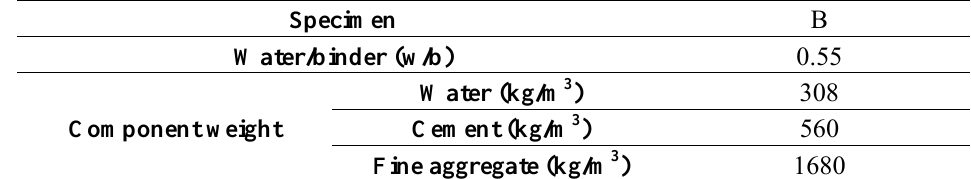
Table 3. Mix design of cement without mineral admixture—Type B specimen.